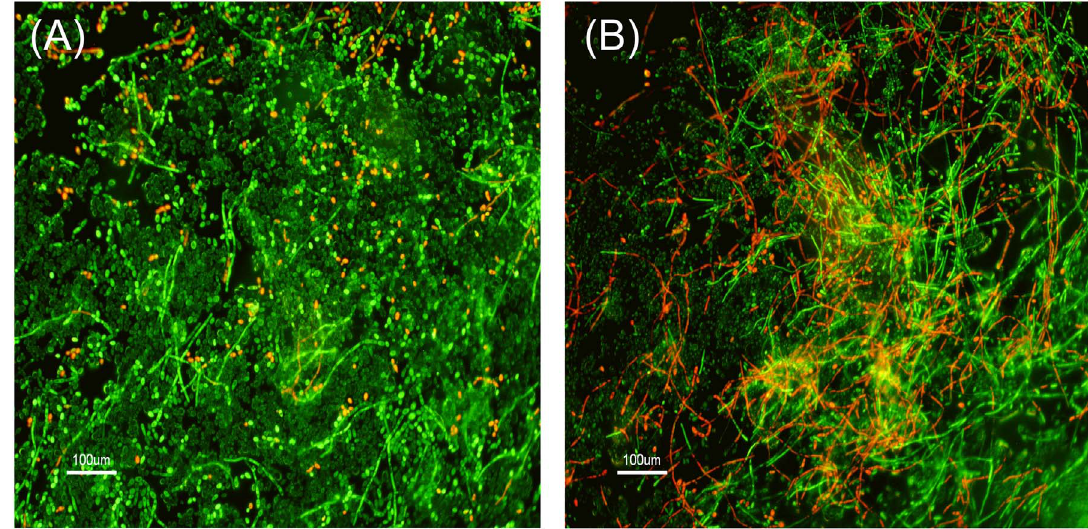
Figure 3. LIVE/DEAD fluorescence imaging of Candidatropicalis 519468. Biofilms were grown for 24 h at 37 u C showing vital live cells (green) versus dead cells (red). (A) Untreated control. (B) 2% OligoG.